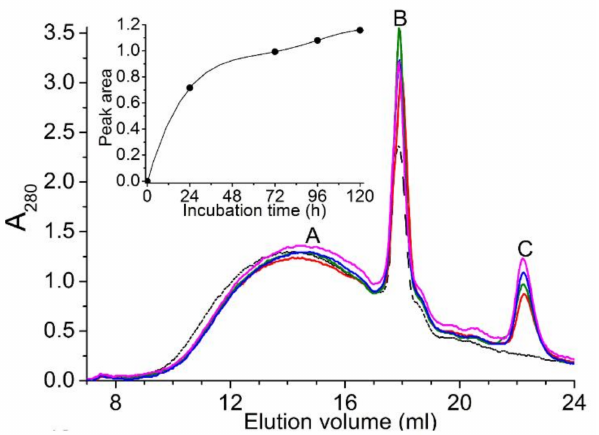
Figure 7. Size-exclusion chromatography profiles of humic acid (HA) degradation by VP, where both MnP and LiP were equally active. Peak A: High molecular weight HA; Peak B: Intermediate molecular weight HA; Peak C: Low molecular weight degradation products of HA. 0 h: Dotted line; 24 h, red; 72 h, green; 96 h, blue; 120 h, magenta. Inset: Productivity of HA degradation as determined by the area under peak C (reproduced from [41] with permission from